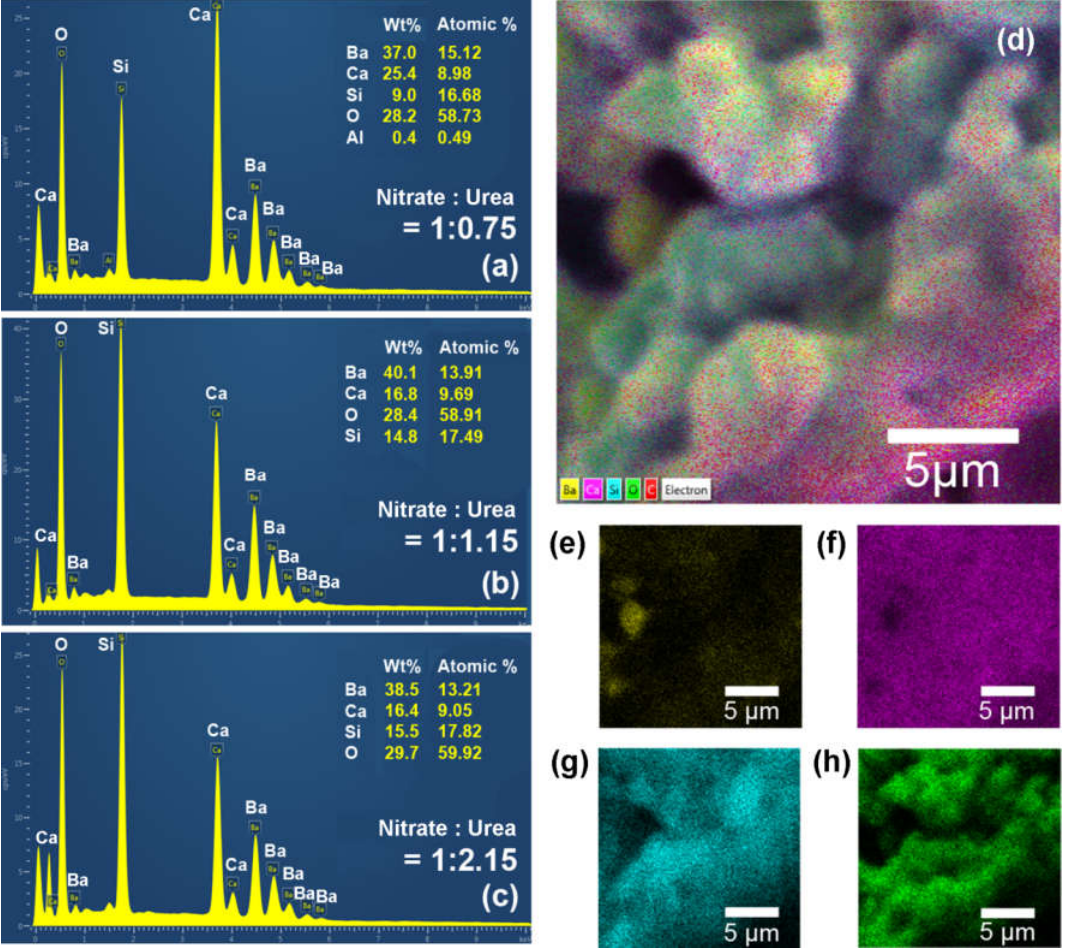
Figure 8. The EDX spectra for τ-phase Ba 1.3 Ca 0.7 SiO 4 powder samples when the molar ratios of